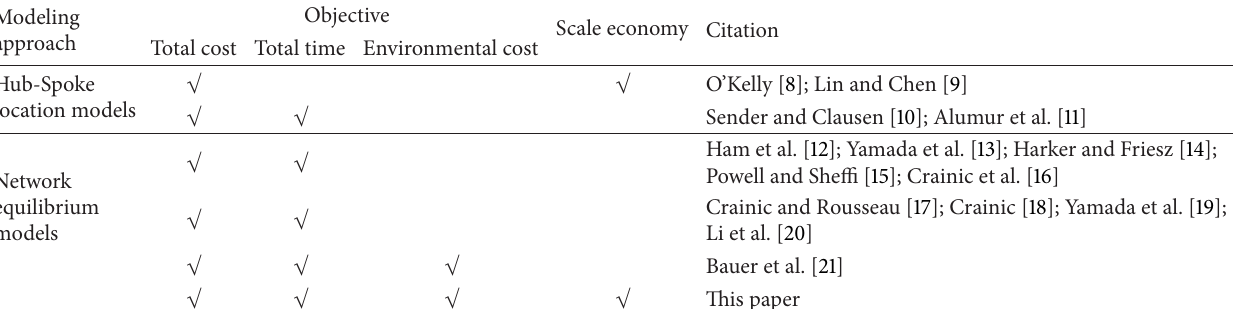
Table 1: Contributions to logistics network design